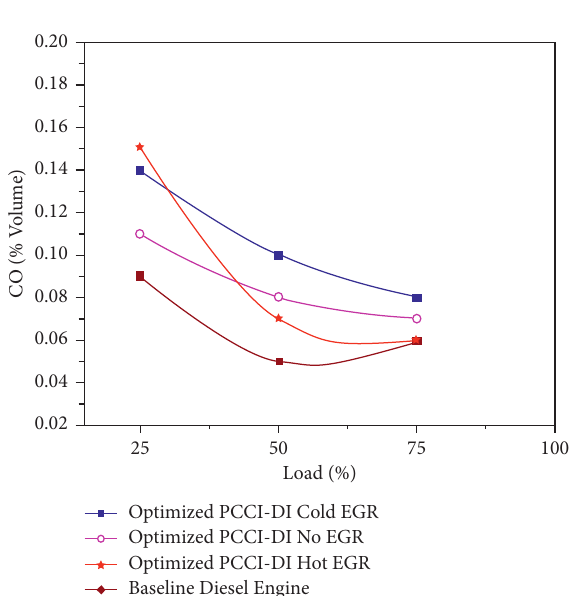
Figure 5: Effects of EGR configurations on CO versus load.